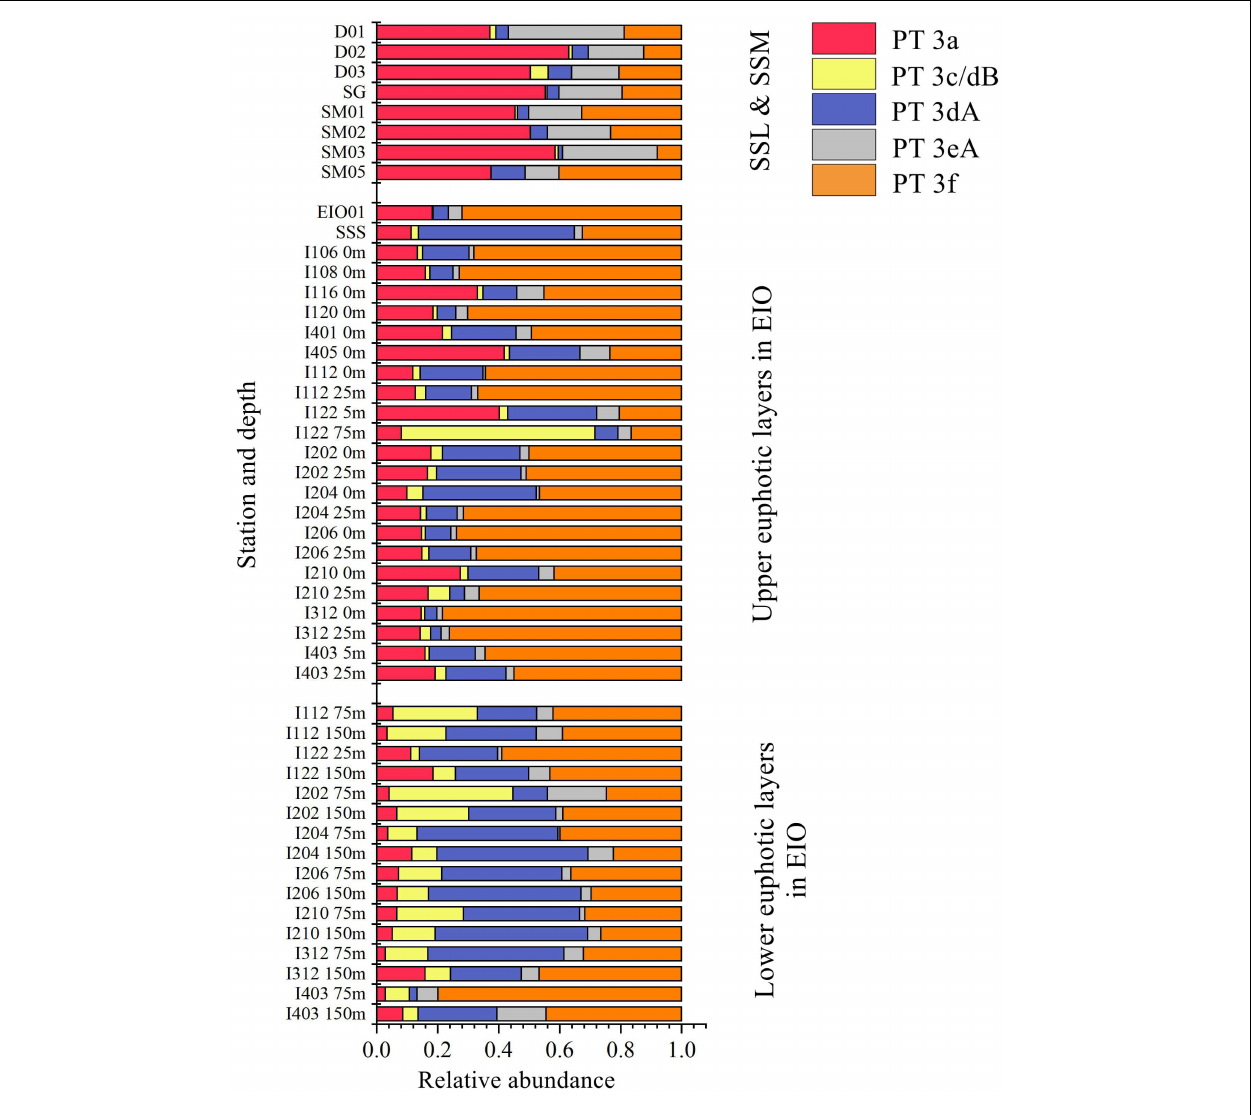
nutrients, suggesting the preference of PT 3f to oligotrophic waters ( Supplementary Figures 3, 4